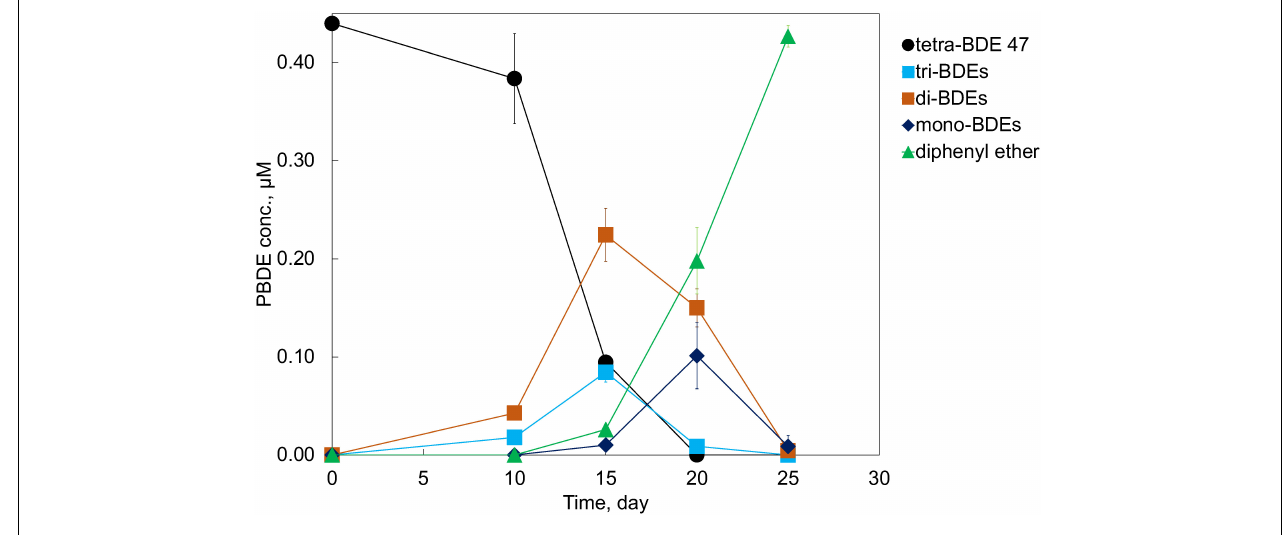
FIGURE 1 | Debromination of tetra-BDE 47 by PB enrichment culture.